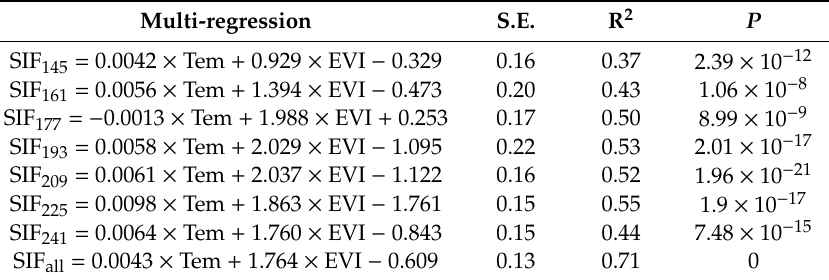
Table 1. Multi-regressions between SIF and EVI and daily mean temperature.